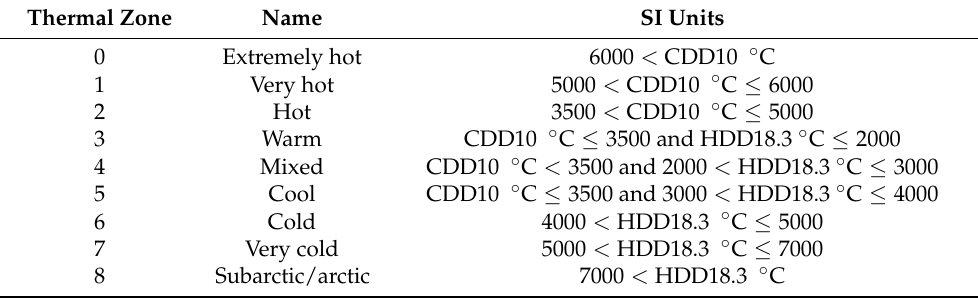
Table 1. Thermal climate zone definitions from ASHRAE STANDARD 169-2021 [16].